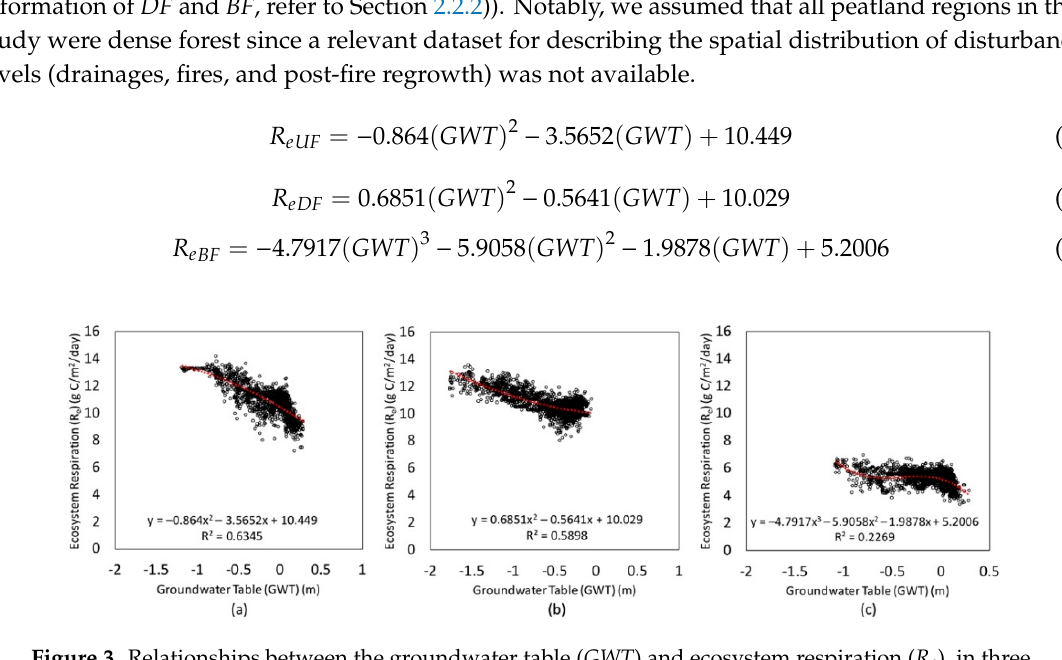
Figure 3. Relationships between the groundwater table ( GWT ) and ecosystem respiration ( R e ), in three di ff erent types of peatlands; ( a ) undrained forest ( UF ), ( b ) drained forest ( DF ), and ( c ) burned forest ( BF ). The regression equations were applied to estimate R e by using a satellite-based GWT in this study.